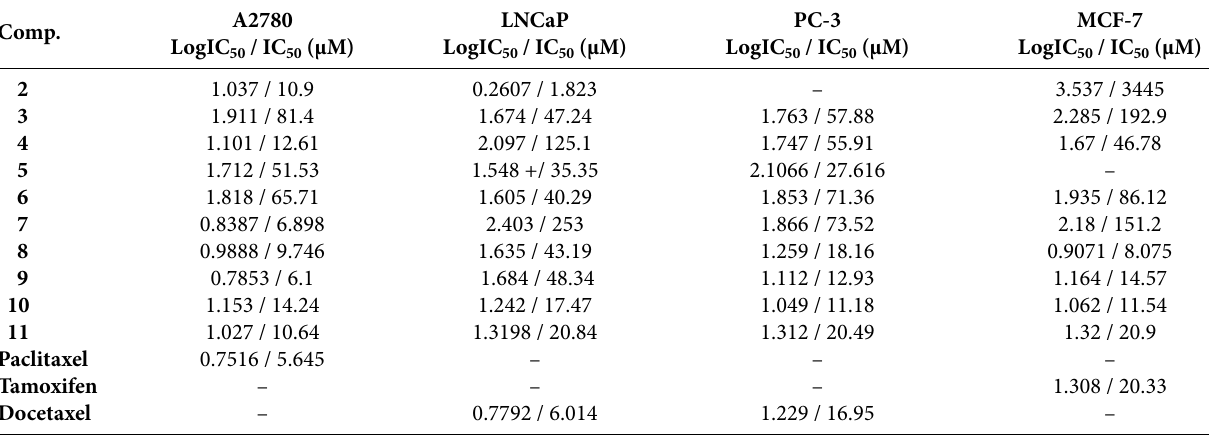
Table 3. The logIC 50 /IC 50 (50% inhibition-causing concentration) values (µM) of compounds 2–11 against A2780, LNCaP, PC-3 and MCF-7 cancer cell lines